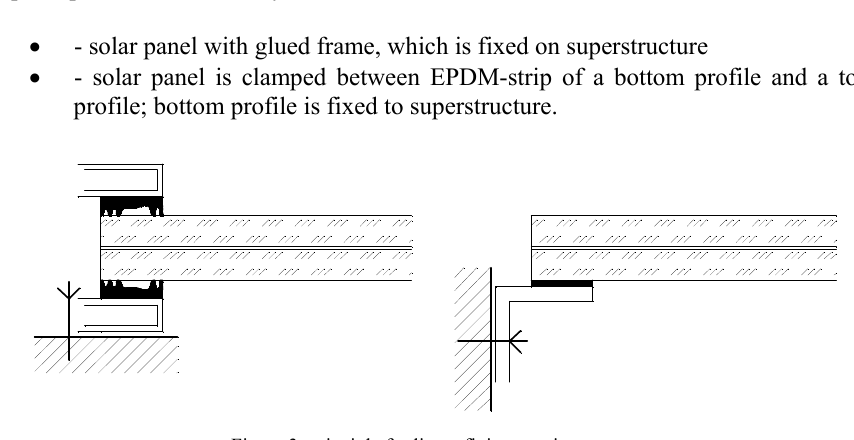
Figure.3: principle for linear fixing, section